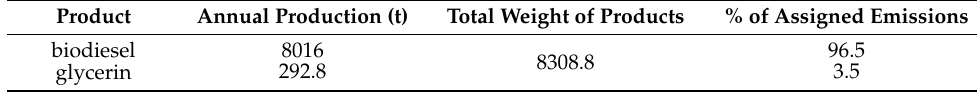
Table 12. Allocation based on the mass